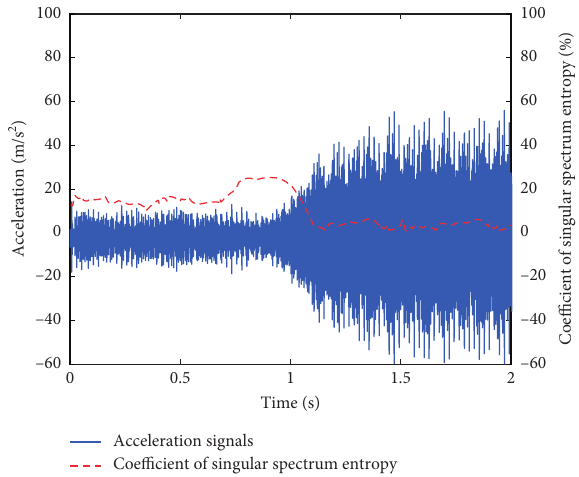
Figure 10: Coefficient of the singular spectrum entropy of each frequency band in the three cutting